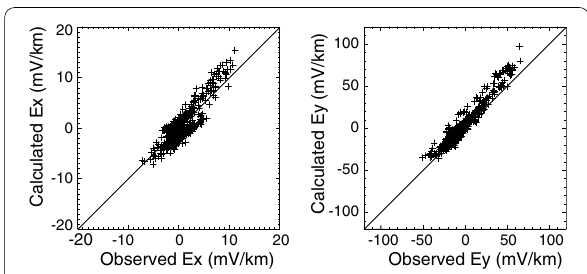
Fig. 3 Relationships between the calculated and observed geoelectric disturbances at Kakioka for (left) the x -component and (right) y -component